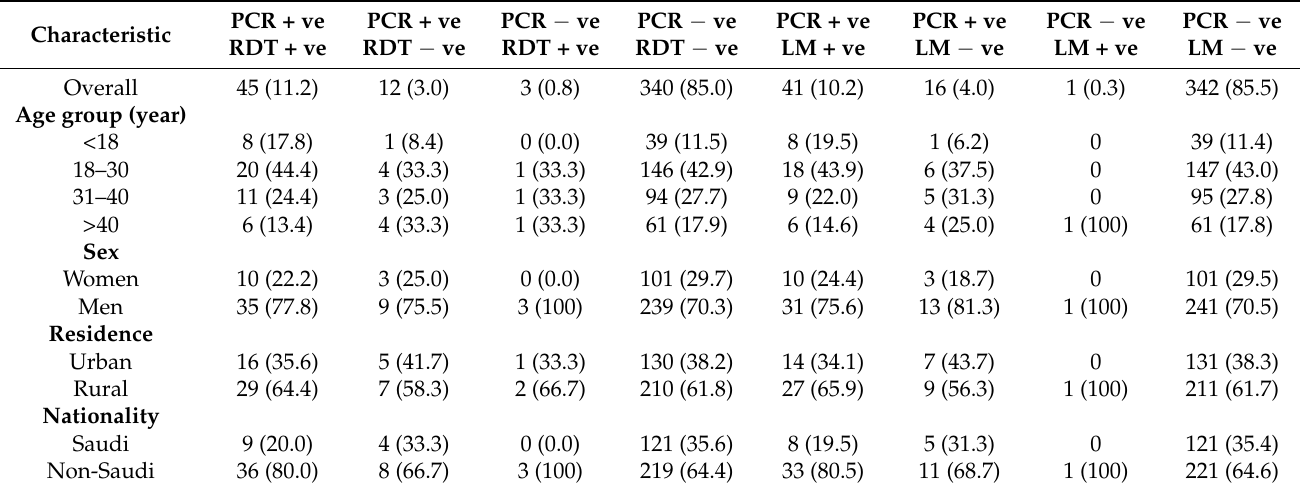
Table 1. Performance matrix of light microscopy and RDT against PCR in the diagnosis of P. falciparum malaria according to participants’ characteristics (n = 400).